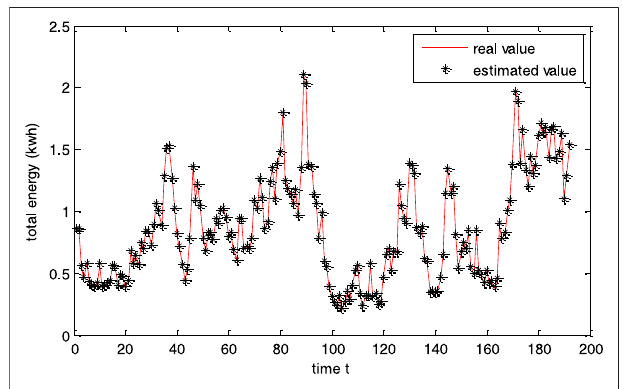
FIGURE 7 | The data from the master meter and the predicted value by the proposed method.